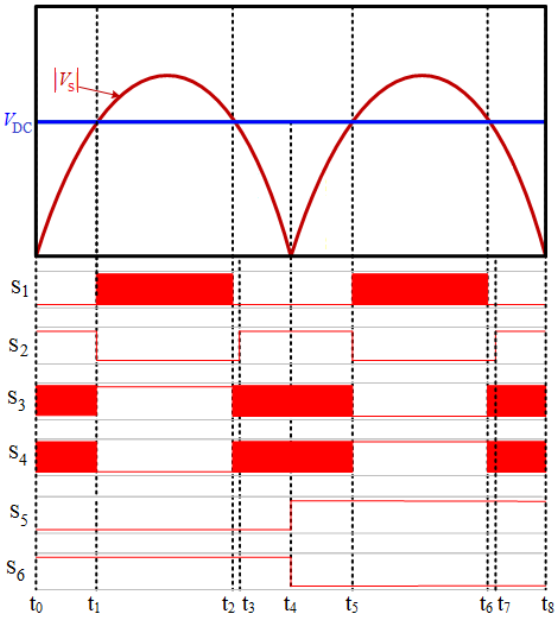
Figure 4. Time diagram for the operation principle of the BBI.